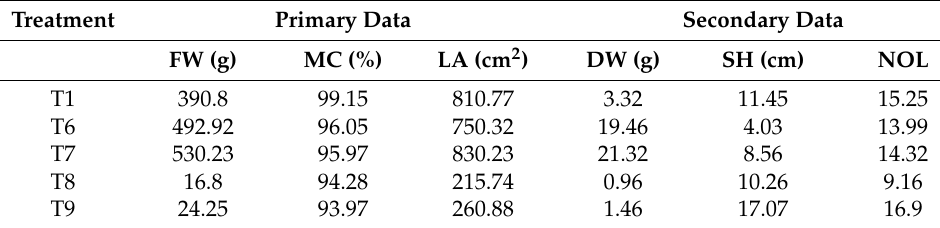
Table 7. Primary and secondary data comparison of growth responses for stop flowering study.